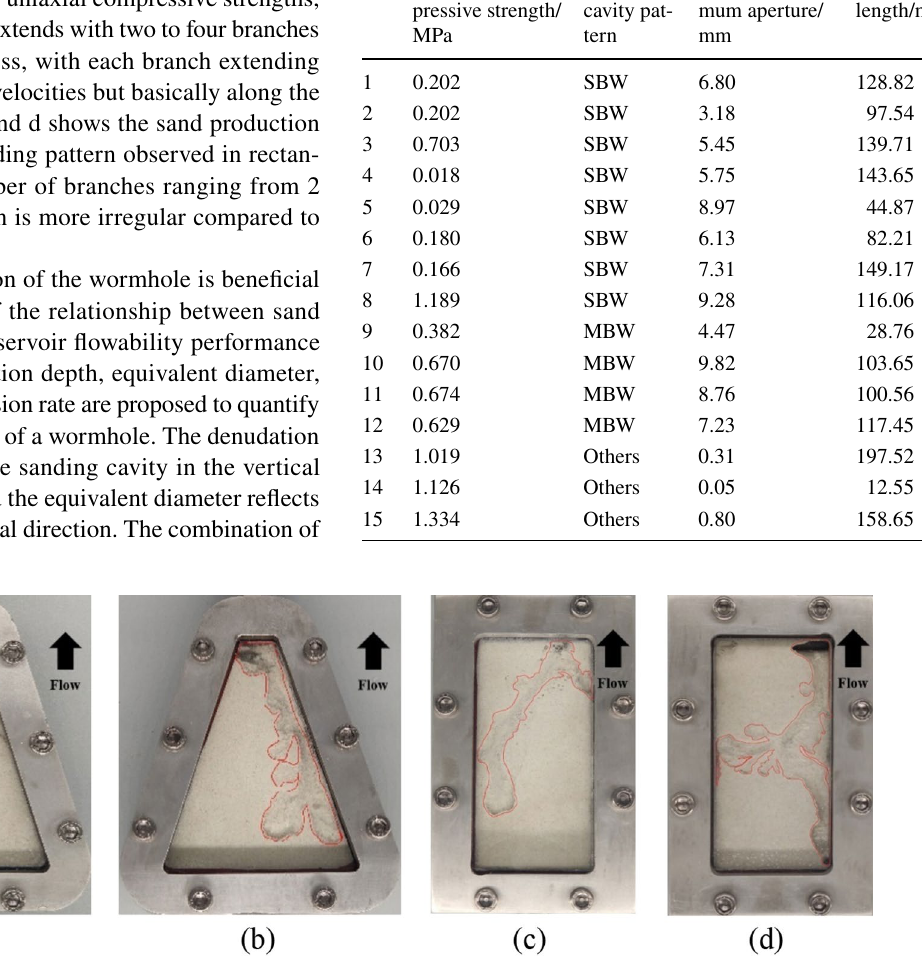
Fig. 6 Multi-branch wormhole sanding cavity in different uniaxial compressive strength samples. a UCS of 0.629 MPa; b UCS of 0.670 MPa; c UCS of 0.382 MPa; and d UCS of 0.674 MPa